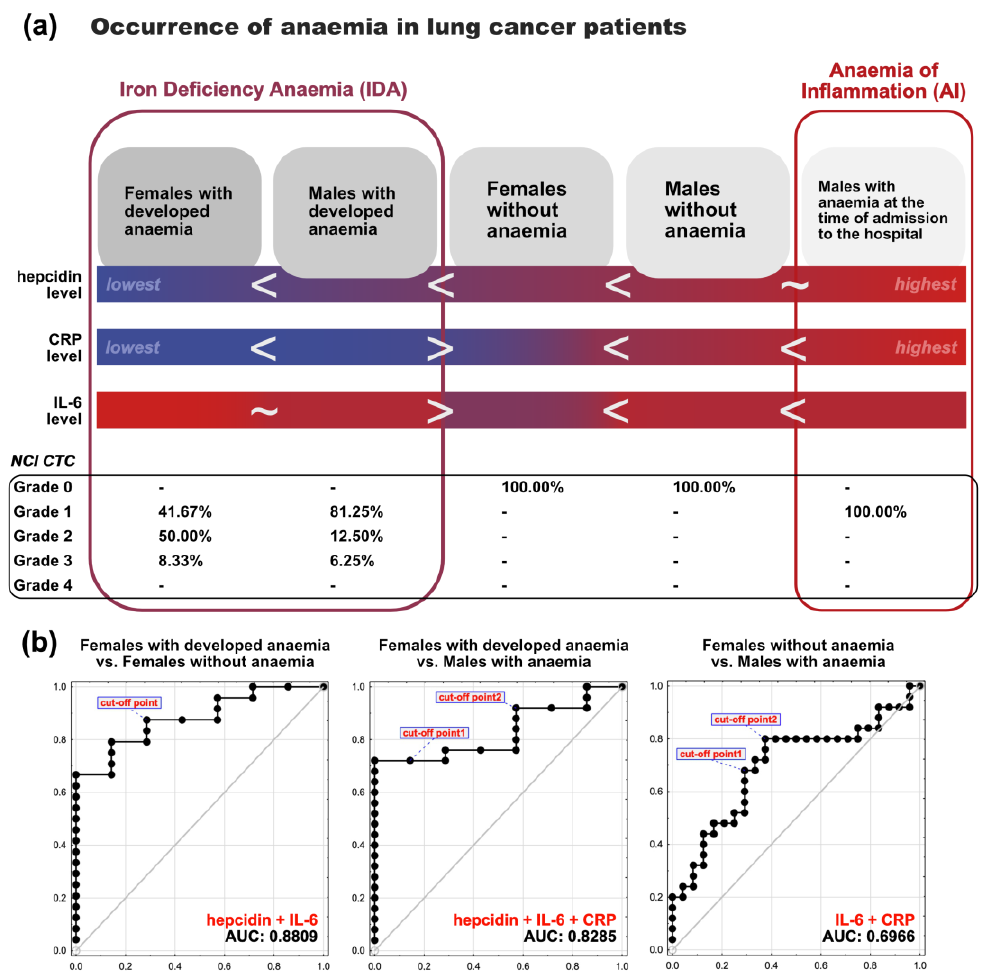
Figure 7. The potential diagnostic model for ( a ) determining the foundation in the pathogenesis of anaemia in lung cancer patients, as well as predicting anaemia severity, and ( b ) distinguishing patients with anaemia since hospital admission from patients with anaemia developed during hospitalization from patients without anaemia during hospitalization.